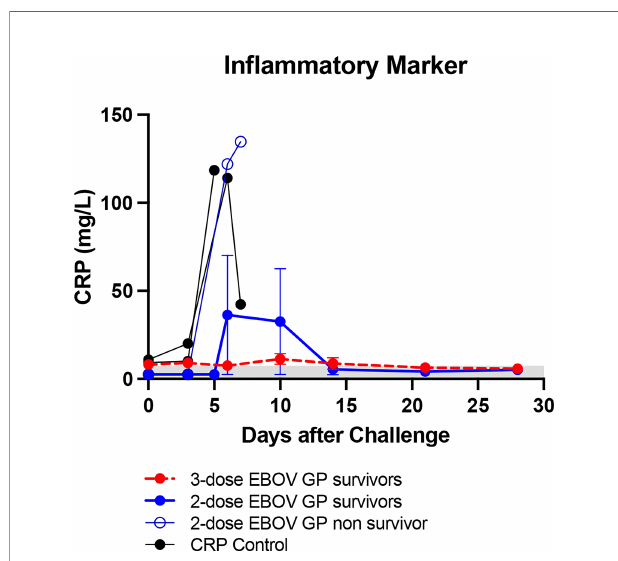
FIGURE 3 | In fl ammatory marker after EBOV challenge. Serum CRP with normal range of 0.0-7.5 mg/L shown as light grey band. Each data point for vaccinated groups represents mean ± SEM. Data points for controls and two-dose non-survivor were plotted individually.